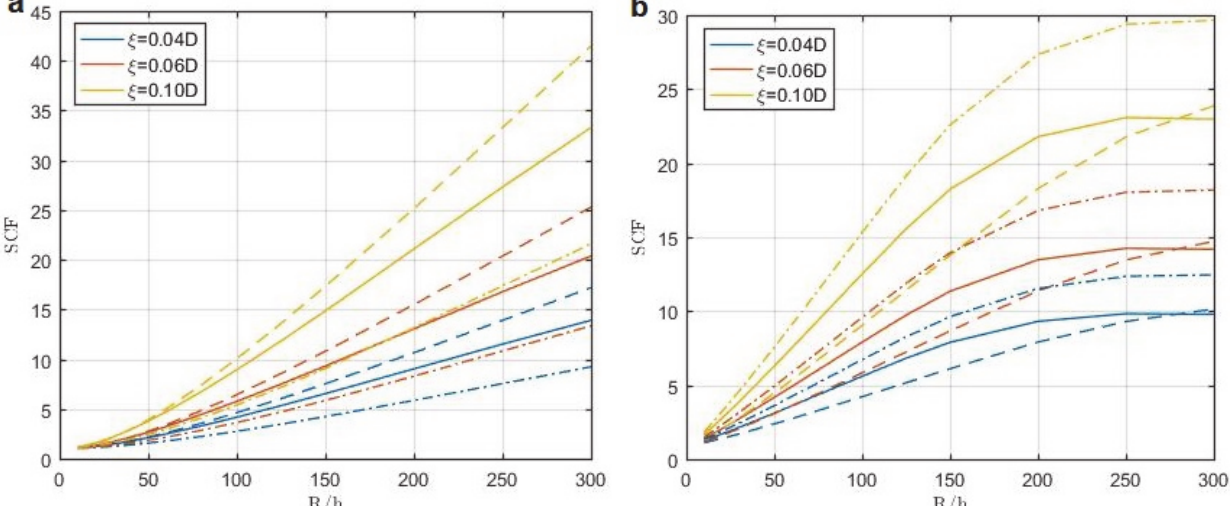
Figure 5: Effect of radius to thickness ration: a) Axial force loading, b) Internal pressure loading; σ nom =1MPa, h =10mm: R 0